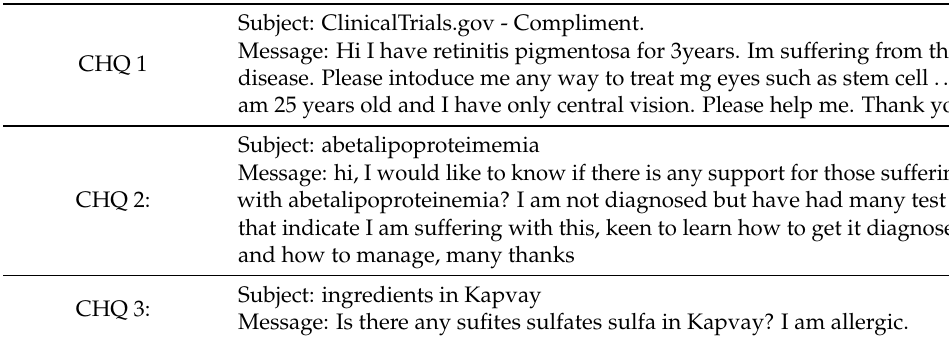
Table 4. TRECQA-2017 dataset